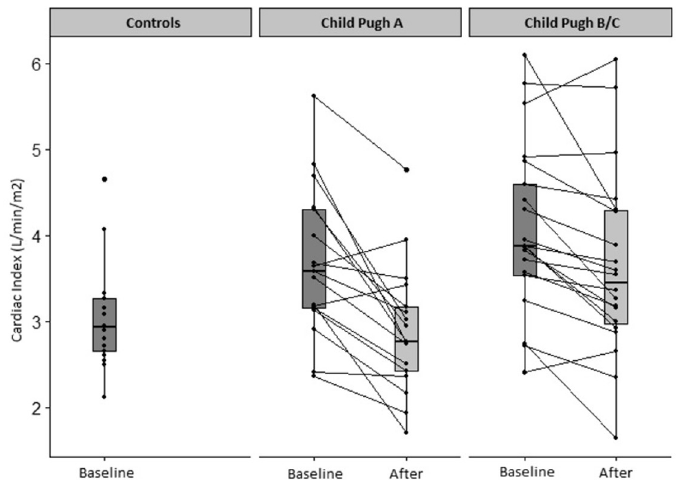
Fig 1. Cardiac index before and after acute beta-blockage. The hyperdynamic syndrome in patients with cirrhosis compared to healthy controls and the effect of beta-blockers on cardiac index among patients with Child-Pugh A (-0.8 ± 0.7 L/min./m 2 (-20.1%), p < 0.001) and Child-Pugh B/C (-0.4 L/min./m 2 (-8.5%), p =